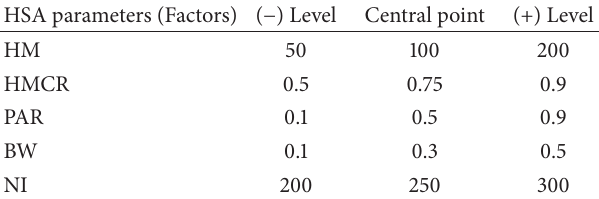
Table 1: Levels of the factors used for the factorial design method.